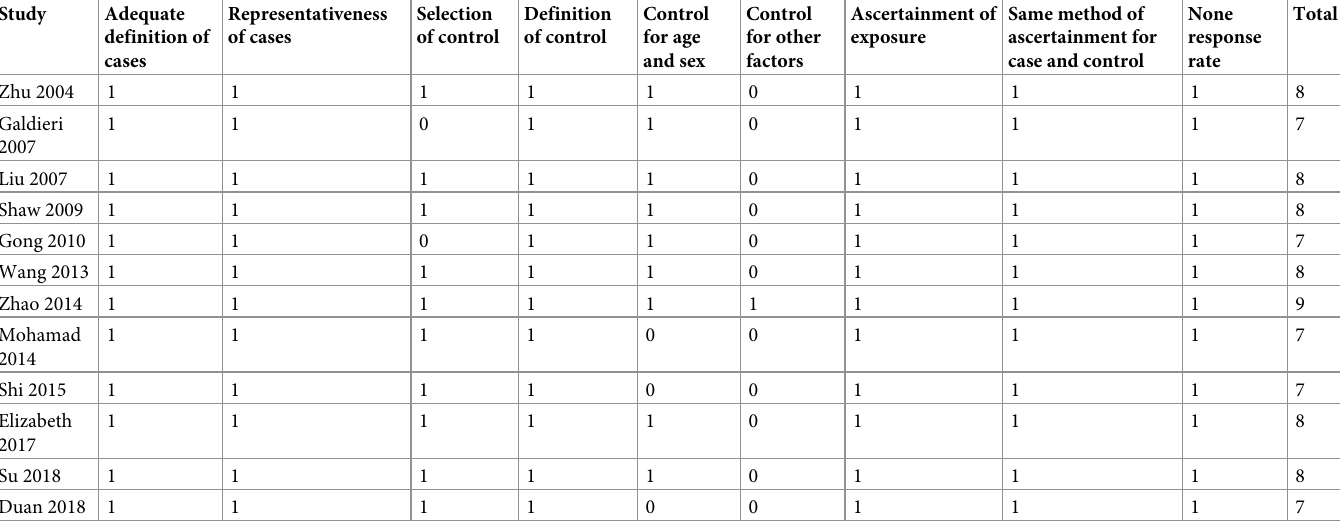
studies ranged from 64 to 2049 and the distributions of the MTR A2756G genotype status for all of the included studies were in agreement with HWE (P all > 0.05). The NOS scores were 7~9 for all of the included studies, indicating good study quality ( Table 2 ). MTR A2756G polymorphism and CHD susceptibility Pooled results from the 14 datasets on 12 case-control studies showed that MTR A2756G poly- morphism was not associated with CHD susceptibility under the allele model (OR: 0.96, 95% CI: 0.86 to 1.07, P = 0.43, I 2 = 4%; Fig 2A ), heterozygote model (OR: 0.95, 95% CI: 0.84 to 1.07, P = 0.41, I 2 = 0%; Fig 2B ), homozygote model (OR: 1.00, 95% CI: 0.64 to 1.55, P = 0.99, I 2 = Table 2. Quality evaluation for the included case-control studies via the Newcastle-Ottawa